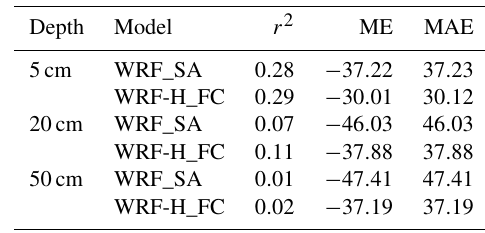
Table 8. Soil moisture performance measures (vol.%) for DE-Fen for June–October 2016.